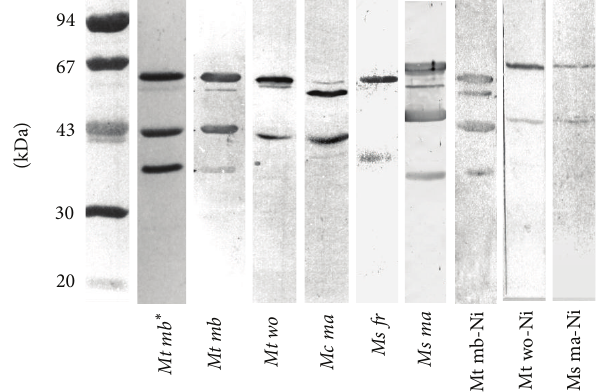
Figure 1: Specificity of the polyclonal serum used for immunolo- calization. The slots depict crude extracts of the organisms after Western blotting of SDS gels and double-immunoperoxidase pre- cipitation. All slots show the typical pattern of MCR. For most organisms (except Ms ma and Mt mb ), only the two larger of the three MCR subunits are visible. When cells were grown on nickel-depleted media, the respective slot is marked with -Ni. The second slot (marked with an asterisk) shows a silver stained SDS- polyacrylamide gel of the purified enzyme. Mt mb: Methanother- mobacter marburgensis , Mt wo: Methanothermobacter wolfei , Mc ma:Methanococcusmaripaludis , Msfr:Methanosarcinamazei (DSM 3318,formerly Methanosarcinafrisia ), Msma:Methanosarcinamazei (DSM 3647).